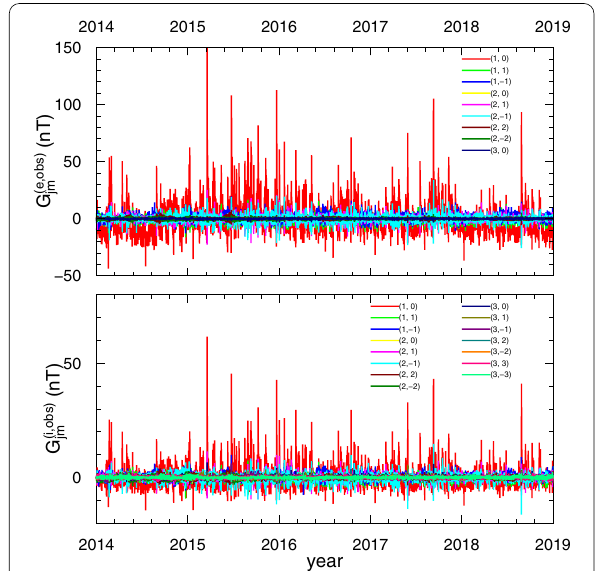
Fig. 1 Time series of external (top) and internal (bottom) field coefficients for CI model 0513, after normalization and